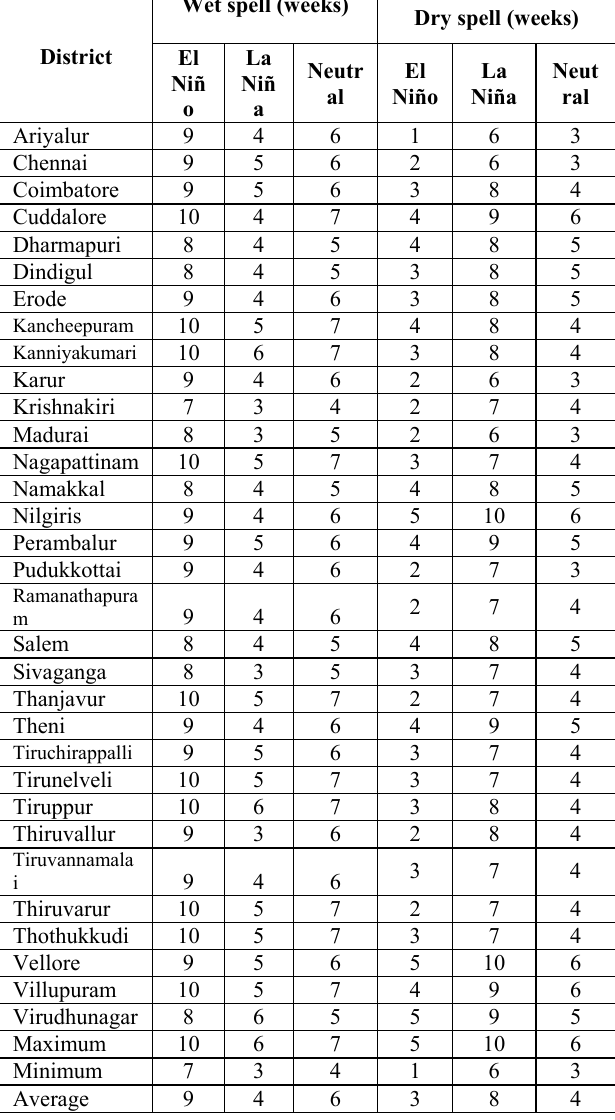
Table 2. Effect of ENSO on wet and dry spells during Rainfed Cropping